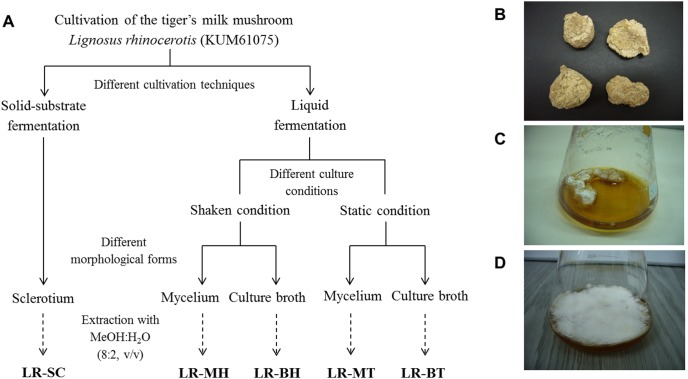
Overview of experimental design.(A) Cultivation of Lignosus rhinocerotis and extraction of low-molecular-weight compounds using aqueous methanol. Extracts were prepared from the mycelium (LR-MH, shaken cultures; LR-MT, static cultures), culture broth (LR-BH, shaken cultures; LR-BT, static cultures), and sclerotium (LR-SC). The different developmental/morphological forms of L. rhinocerotis: (B) sclerotium from solid-substrate fermentation, (C) mycelial pellet in shaken cultures, and (D) mycelial pellicle in static cultures of liquid fermentation.